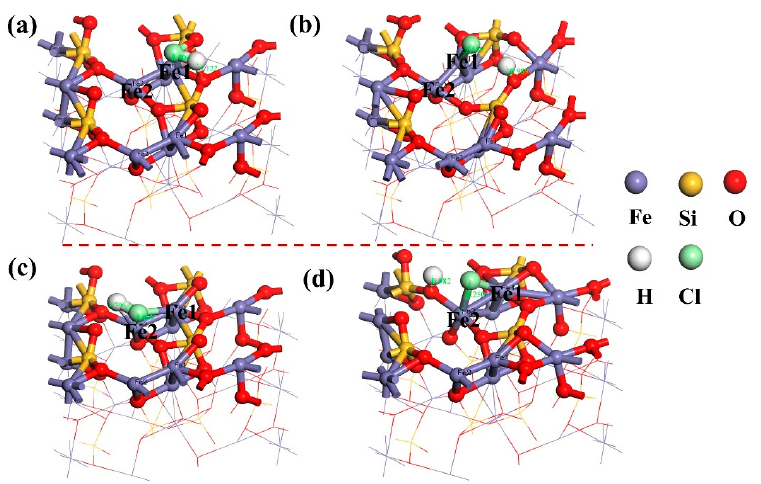
Figure 6. HCl adsorption on Fe 2 SiO 4 : ( a ) Configuration of HCl adsorption on Fe1 site before optimization. ( b ) Configuration of HCl adsorption on Fe1 site after optimization. ( c ) Configuration of HCl adsorption on Fe2 site before optimization. ( d ) Configuration of HCl adsorption on Fe1 site after optimization.